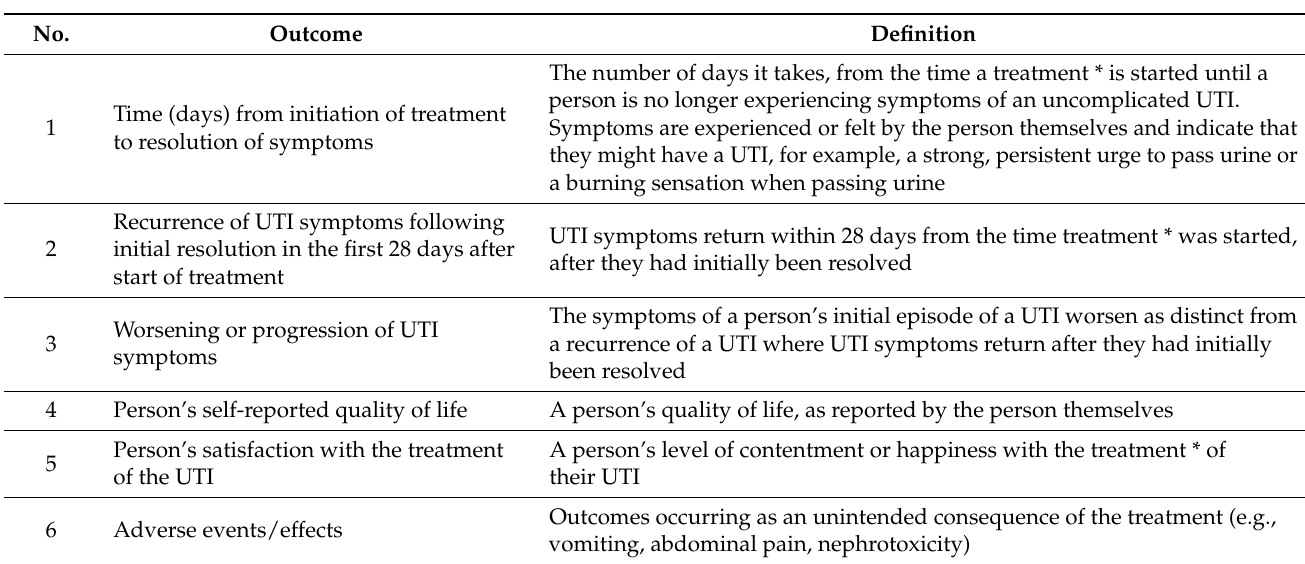
Table 1. Final COS to be included in future research on interventions for treating uncomplicated UTI in adults.